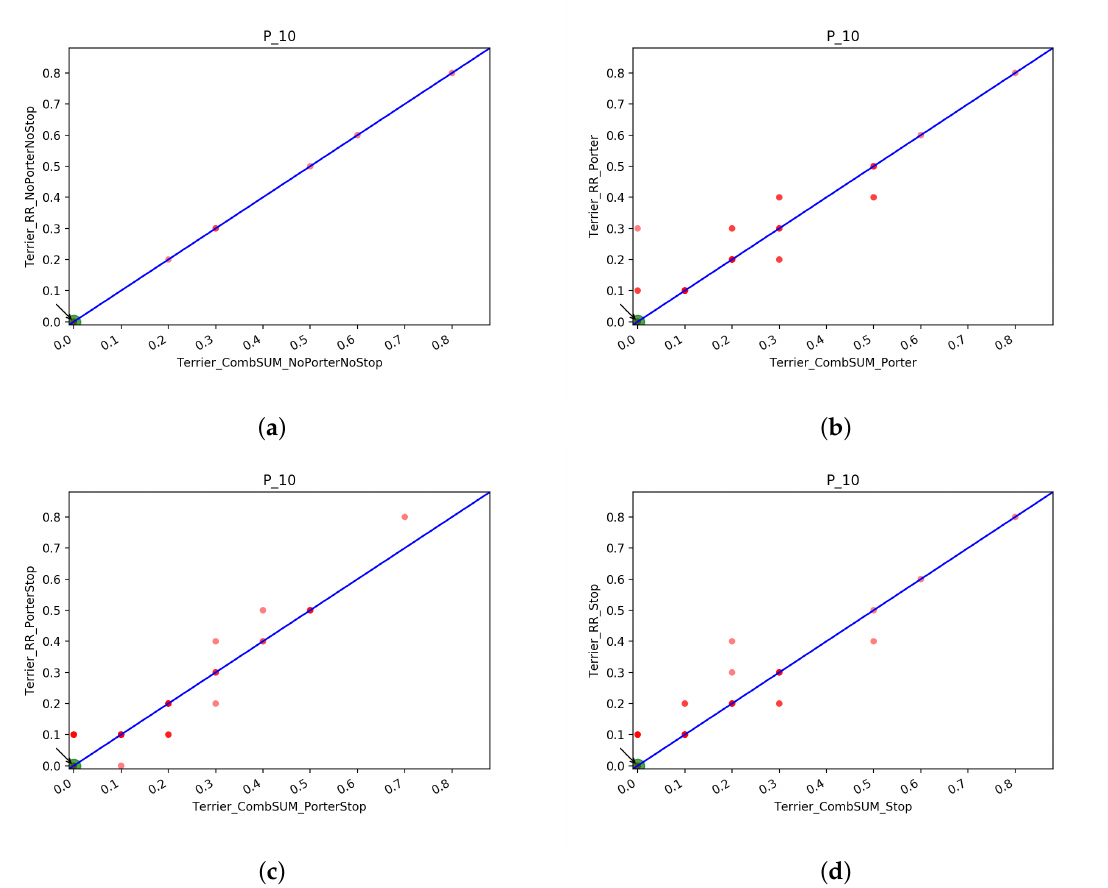
Figure 20. T1: scatter plots of P@10 of the fusion of all the models using the same index: ( a ) CombSUM vs. RR fusion of the Terrier runs using NoPorterNoStop index NoPorterNoStop fusions of the runs, ( b ) CombSUM vs. RR fusion of the Terrier runs using Porter index, ( c ) CombSUM vs. RR fusion of the Terrier runs using PorterStop index, ( d ) CombSUM vs. RR fusion of the Terrier runs using Stop